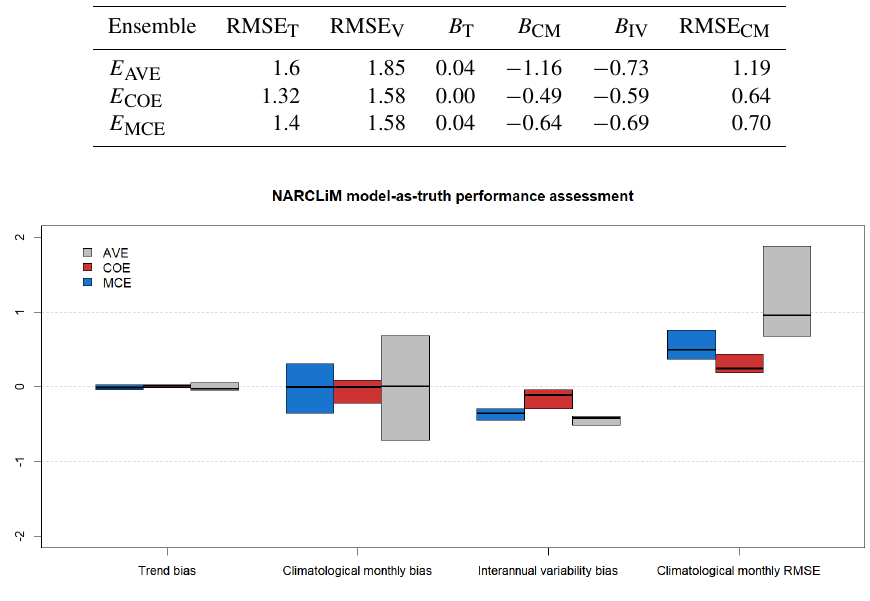
Figure 6. NARCLiM model-as-truth performance assessment results. Median, 25% and 75% percentiles of the N = 12 models.